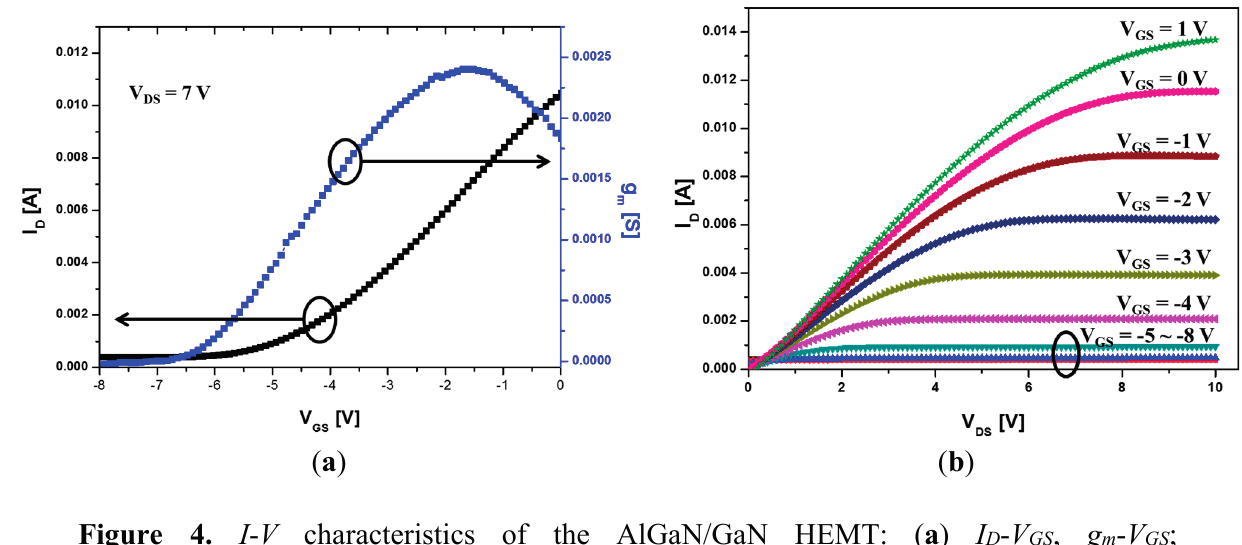
( a ) ( b ) Figure 4. I - V characteristics of the AlGaN/GaN HEMT: ( a ) I D - V GS , g m - V GS ; ( b ) I D - V DS characteristics.